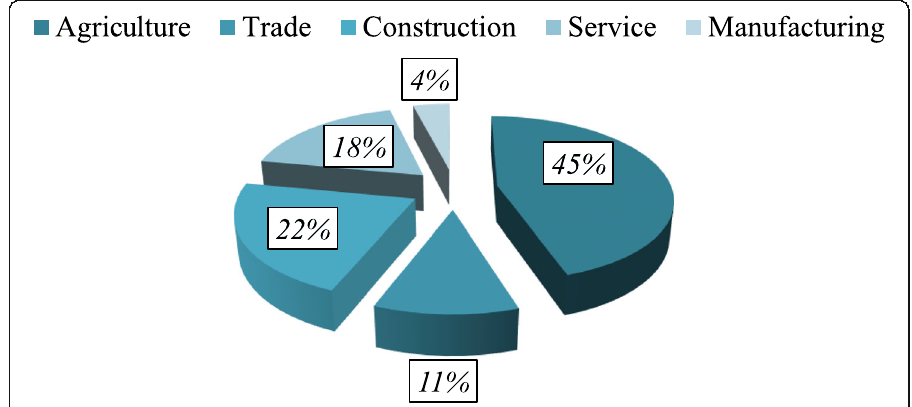
Fig. 2 Sectoral engagement of enterprises. Source: author ’ s computation based on firm survey (2018)